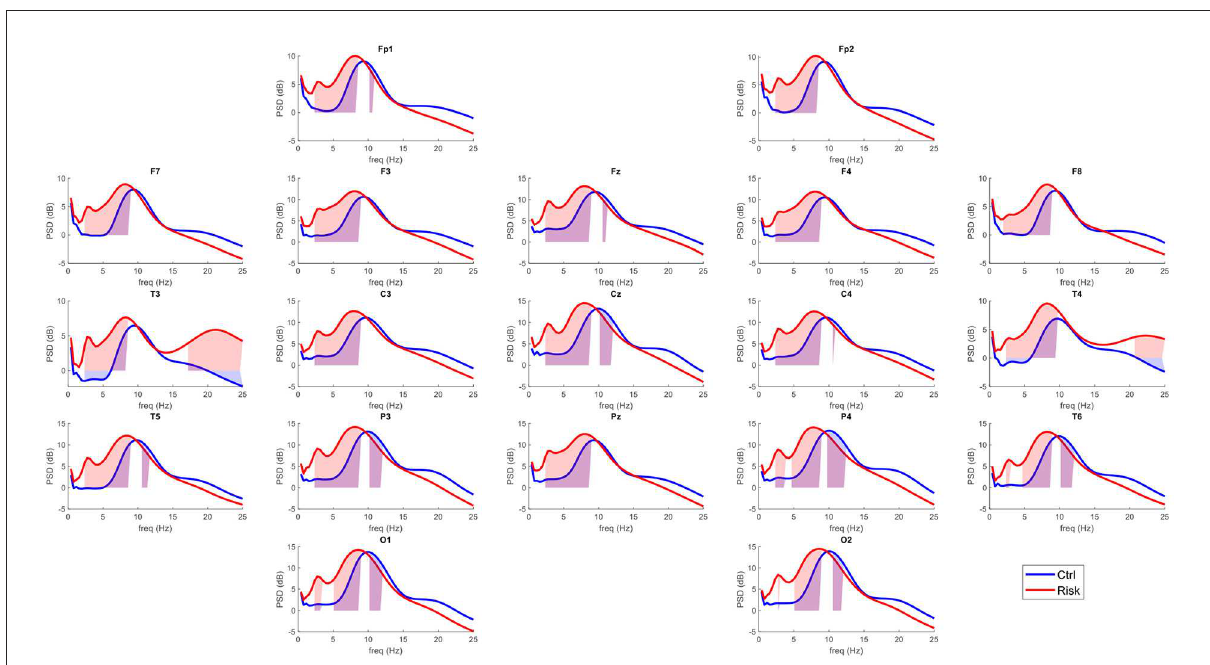
FIGURE1 Average power spectra per group in the surface level EEG. In red, average power spectra across the 19 leads of the International 10–20 system for the risk group (RG). In blue, average power spectra for the control group (CG). The shaded areas represent the frequencies that exceeded the probability threshold ( p = 0.05).